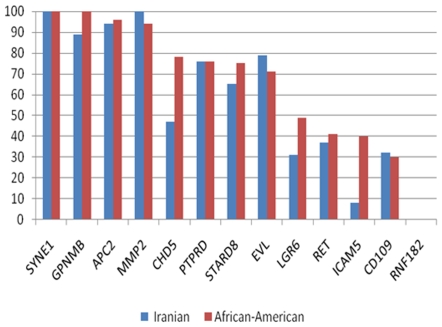
Graphical presentation of methylation frequencies (%) of the CAN genes in the studied populations.